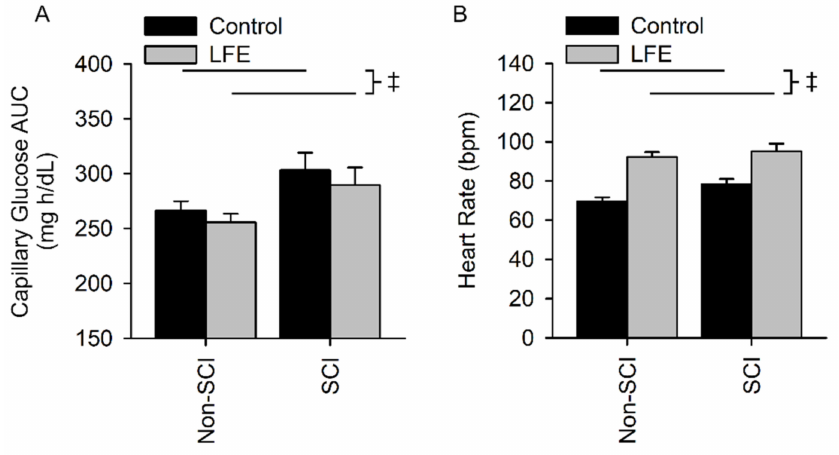
Figure 5. Capillary Glucose Area Under the Curve (cAUC) and Heart Rate. There was no interaction for cAUC ( A ) and maximum heart rate ( B ). However, people with SCI cAUC and maximum heart rate compared to the non-SCI participants. ‡ Indicates a significant difference ( p ≤ 0.05) of the indicated main effect and no significant interaction between session and